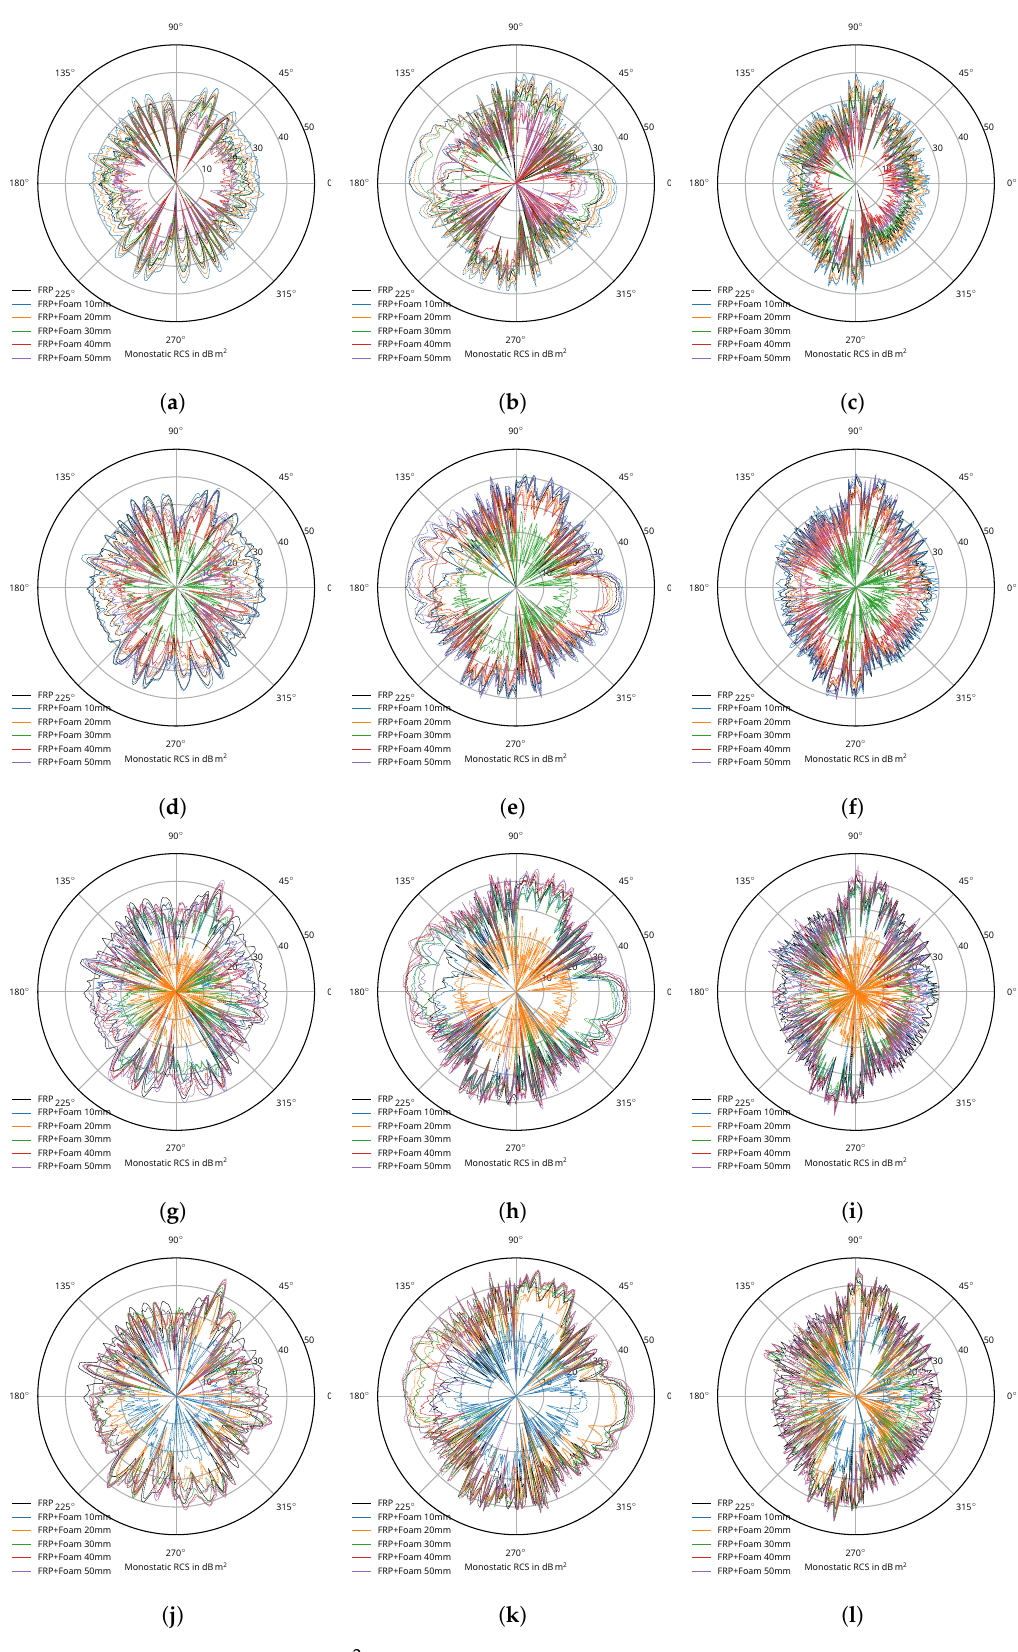
Figure 7. Monstatic RCS (in dBm 2 ) of the rotor blades (left to right) composed of a sandwich